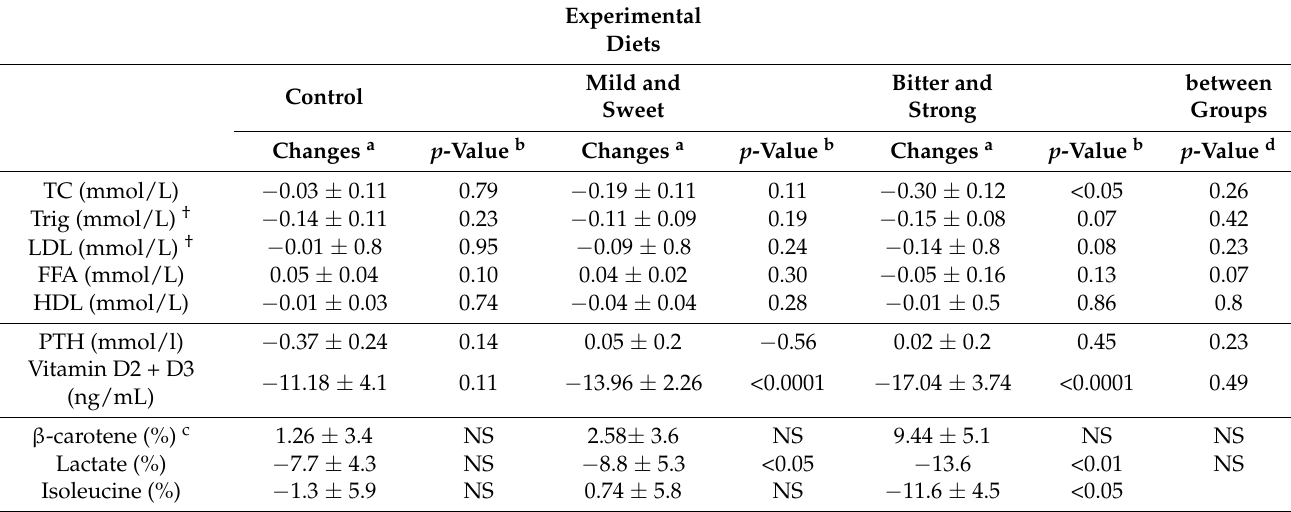
Table 5. Changes ( ∆ ) in lipids, PTH, vitamin D, β -carotene lactate, and isoleucine after a 12-week